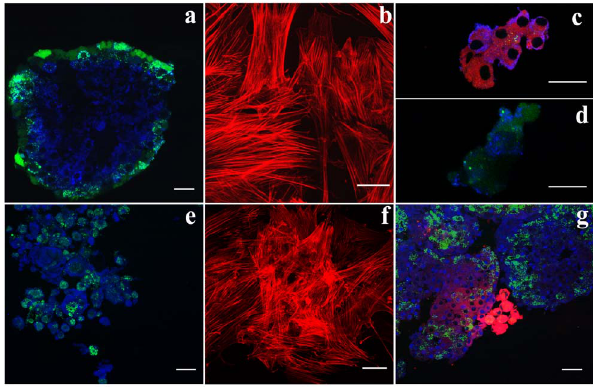
Figure 4. Insulin and Pdx1 detection. Insulin positive cells in pancreatic islets (a), in MSCs (b), and in direct co-cultures of pancreatic islets and MSCs (c and d). In green, calcein positive pancreatic islets. In red, MSCs stained with DiI. In blue, insulin positive cells. Bar 30 m m. Pdx1 positive cells in pancreatic islets (e), in MSCs (f), and in direct co- cultures of pancreatic islets and MSCs (g). In green, calcein positive pancreatic islets. In red, MSCs stained with DiI/Phalloidin. In blue, Pdx1 positive cells. Bar 30 m